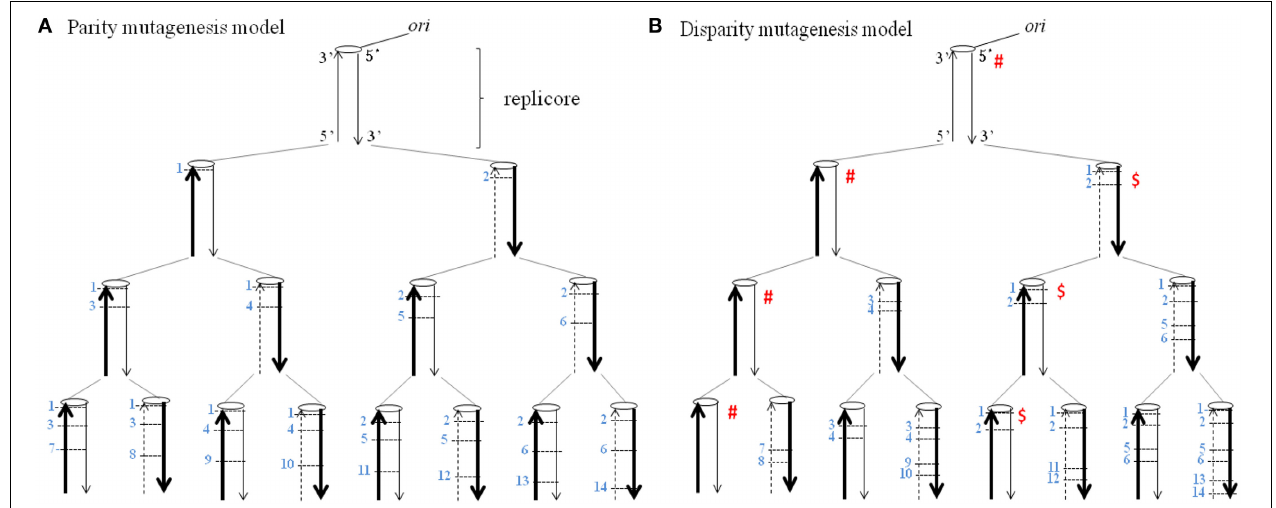
FIGURE 1 | The distribution of mutations according to the deterministic model of a single replicore is shown. A broad arrow indicates a template DNA strand, a thin arrow indicates a newly synthesized leading strand and a dashed thin arrow indicates a newly synthesized lagging strand. Each number on the side of a short horizontal bar indicates a base substitution at a different site. The ori